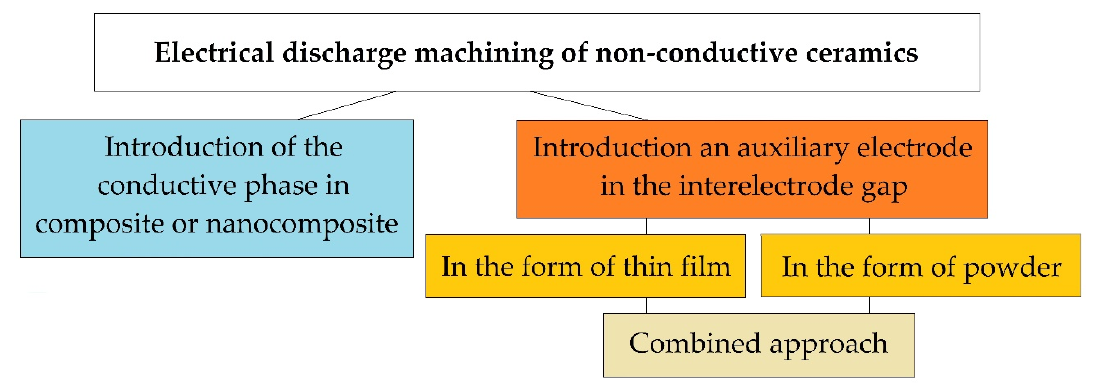
Figure 2. Electroerosive methods for processing non-conductive ceramics.